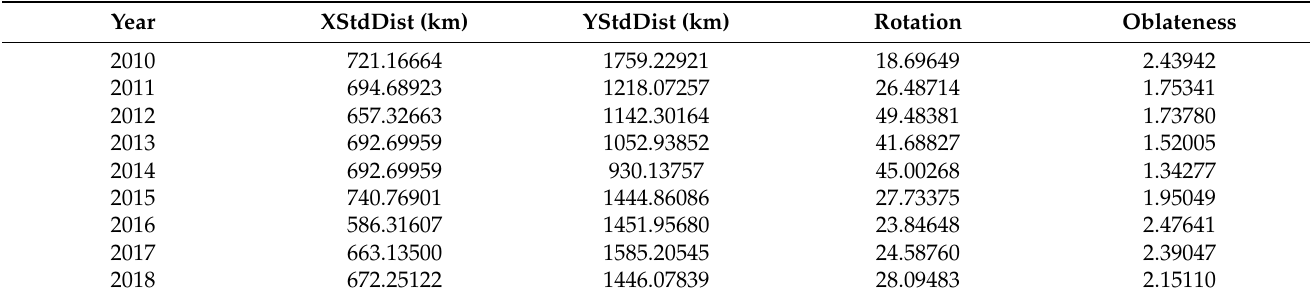
Table 1. Standard deviation for oval-shaped parameters of forest fi re occurrence in mainland China, 2010–2018.